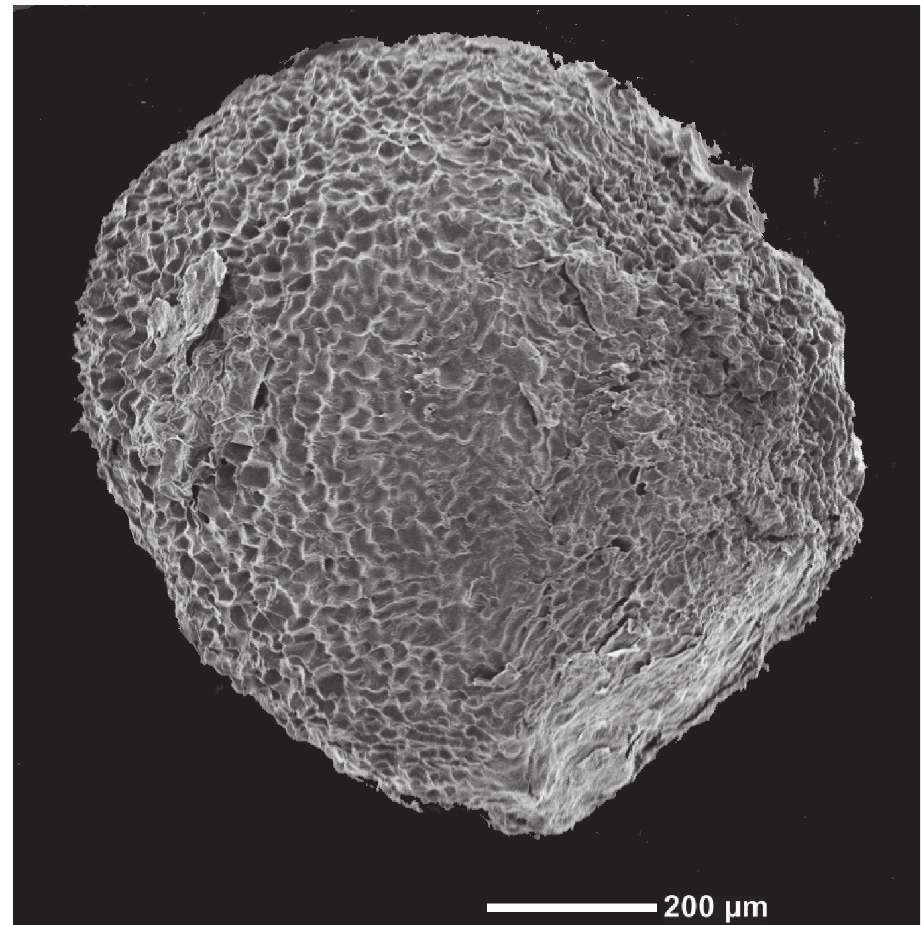
Figure 2. Scanning electron micrograph of a seed of Miconia machinazana (photograph O.A.